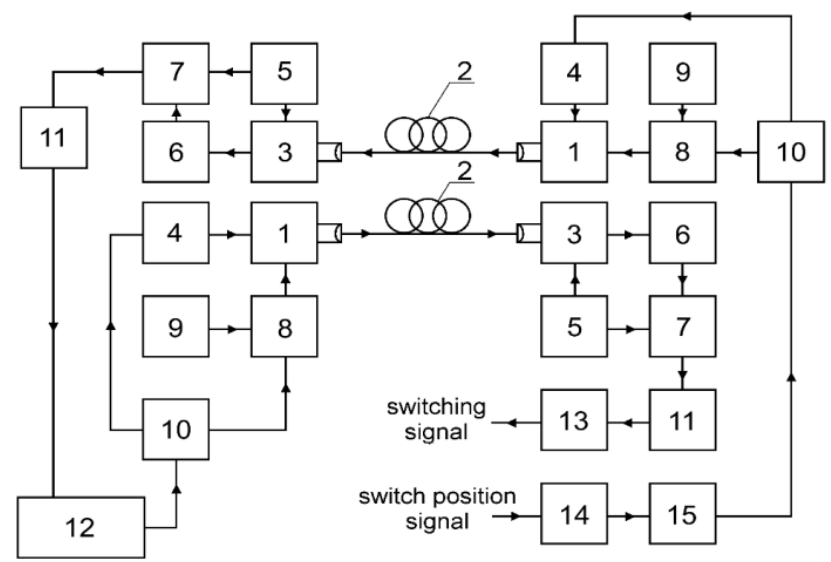
Figure 3. Structural diagram of an analog FOCL for controlling and monitoring the operation of key elements: 1 — semiconductor laser; 2 — optical fiber; 3 — photodetector module; 4 — laser power supply unit with direct current modulation; 5 — multifunctional power supply; 6 — tunable LC filter; 7 — analog- to-digital converter (ADC); 8 — electronic key; 9 — subcarrier frequency signal generator; 10 — the device for forming a sequence of rectangular pulses; 11 — the device for processing information obtained using a sequence of command codes; 12 — dispatcher ’ s central computer; 13 — device for generating switching signals of key elements; 14 — device for generating data from key elements; and 15 — information pro- cessing device.